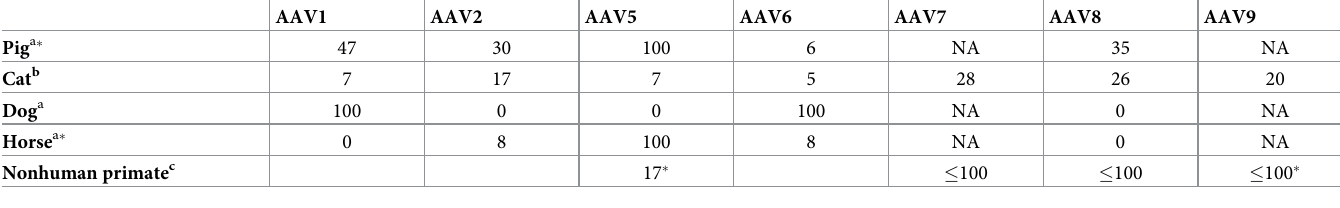
Table 3. Overview of the prevalence (in %) of NAb to AAV in various animal